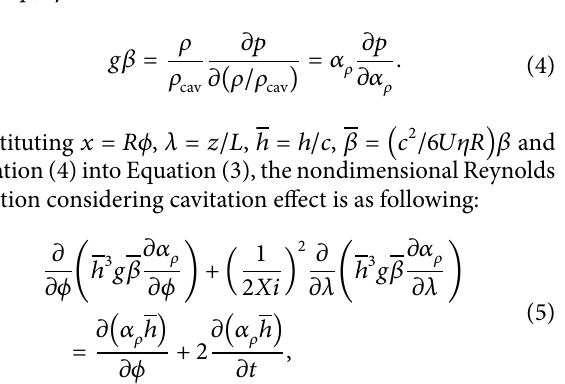
Figure 3: Influence of rotating speed n on the volume fraction of cavitation in N-S model. (a) = 6000 (c) 𝑛